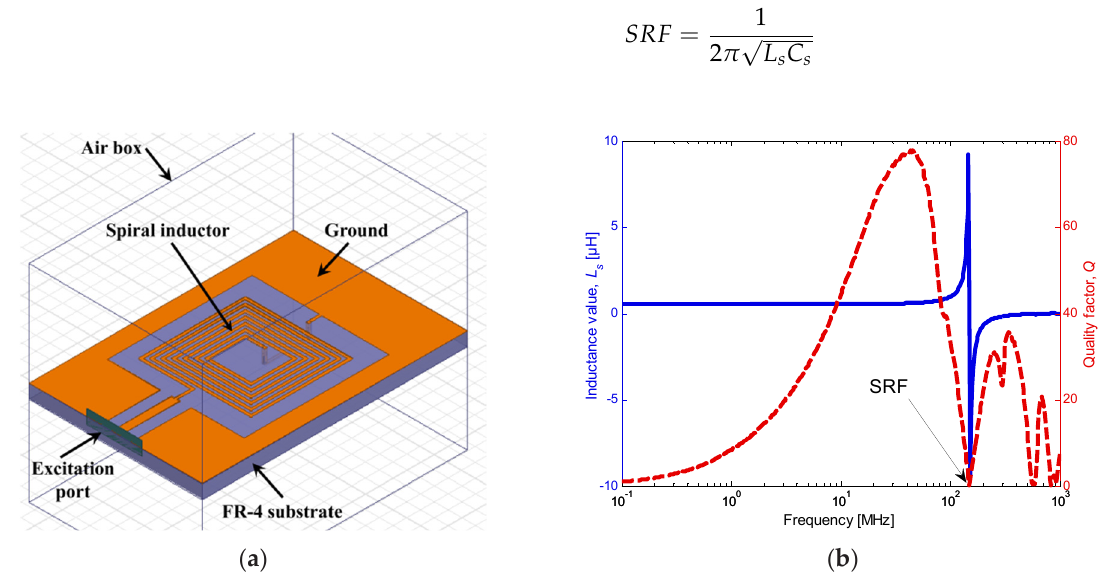
Figure 2. Spiral inductor topology: ( a ) design in HFSS and ( b ) simulated inductance variation and quality factor versus frequency.